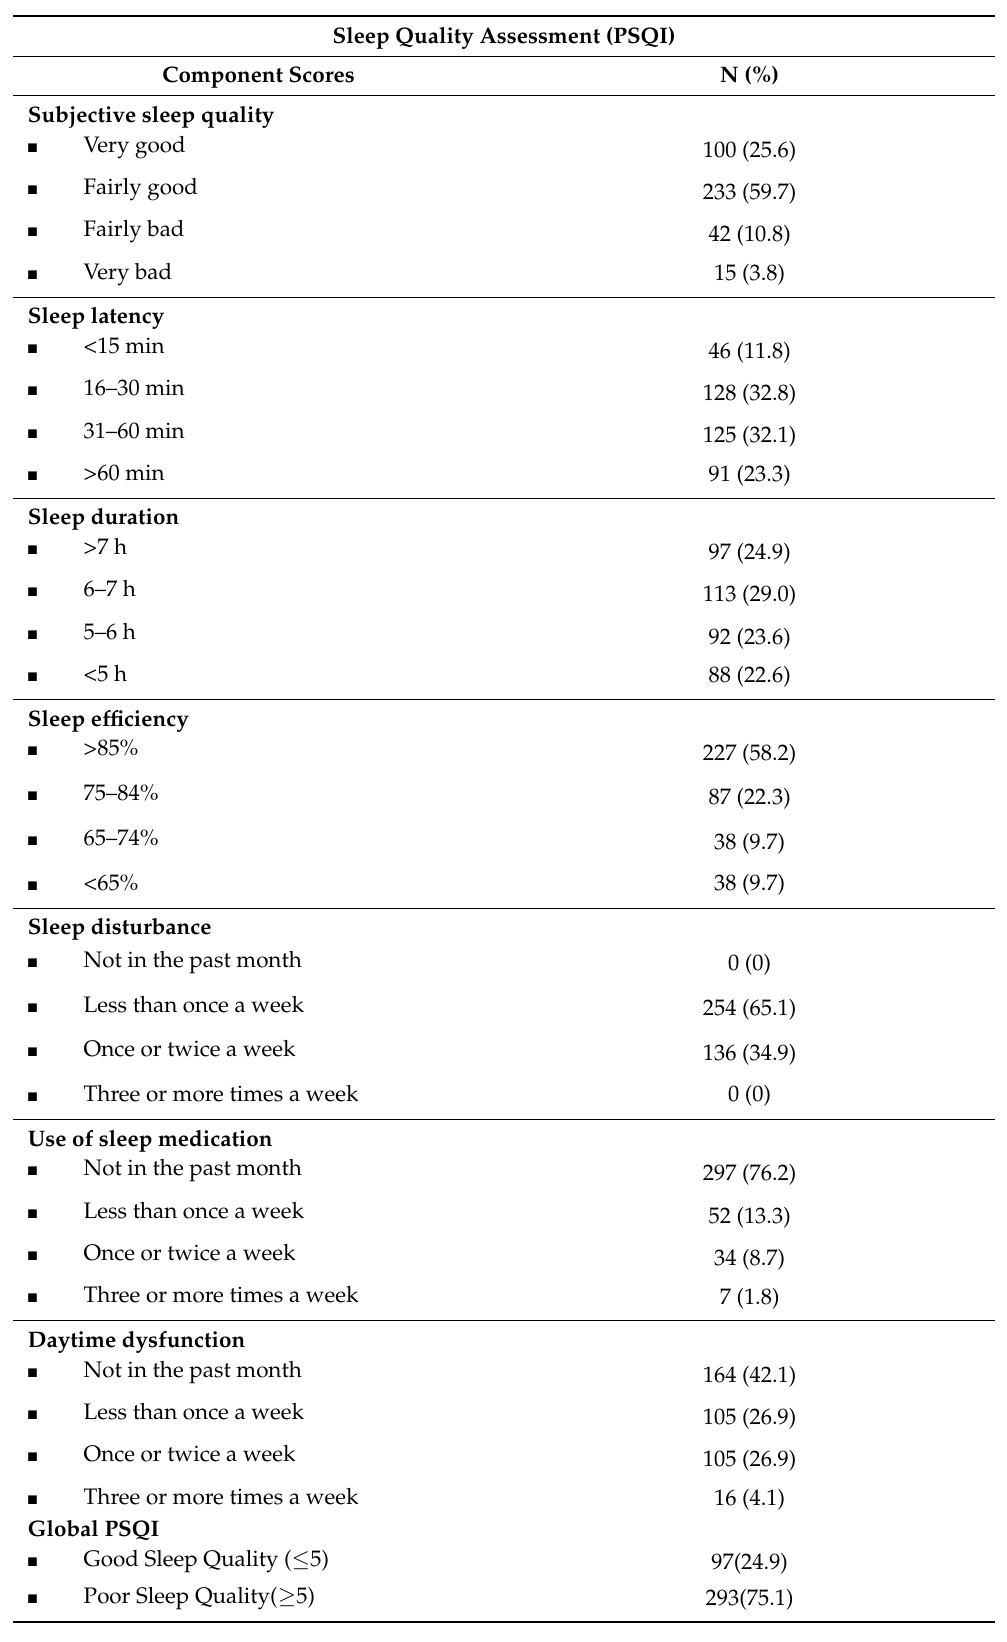
Table 2. Distribution of sleep quality assessment (PSQI) of patients with chronic respiratory disorders (N =